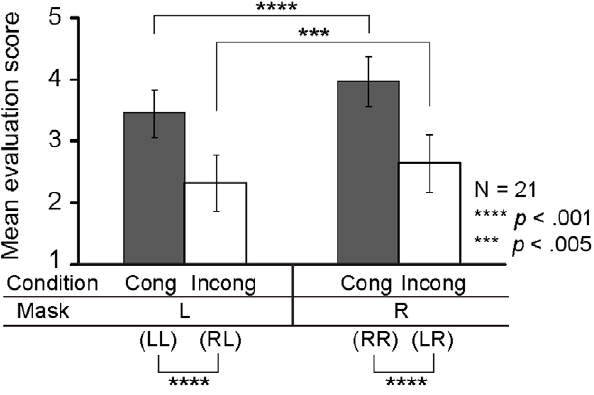
Figure 5. Mean evaluation scores in the practice phase. RR and LL conditions are congruent-green conditions and LR and RL conditions are incongruent-blue conditions. Error bars indicate the SDs of the evaluation scores across participants. Cong and Incong denote congruent-green and incongruent-blue conditions, respectively.